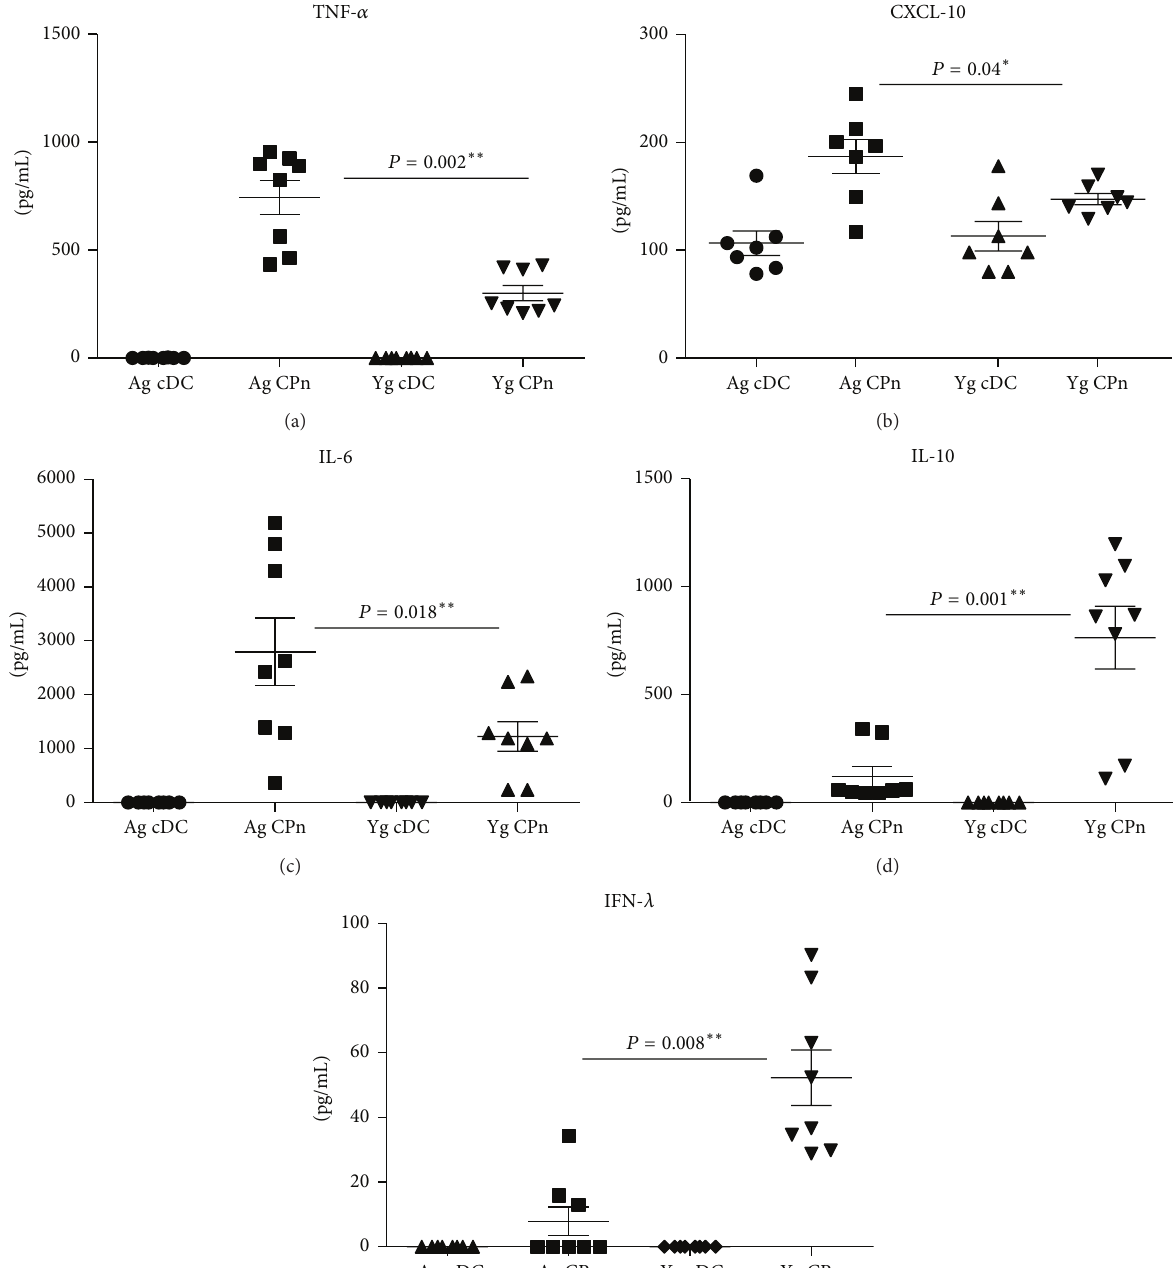
Figure 3: Conventional Myeloid DCs (cDCs) from the blood of aged subjects also display enhanced inflammatory responses to CPn. Graphs depict the levels of cytokine and chemokines secreted by CPn-stimulated cDCs purified directly from the blood of aged and young subjects. (a) TNF- 𝛼 ; (b) CXCL-10; (c) IL-6; (d) IL-10; (e) IFN- 𝜆 ; Each dot corresponds to a separate subject. Data is of 8 aged and 8 young subjects. 𝑃 value depicted is comparison of CPn-stimulated DCs from aged with their young